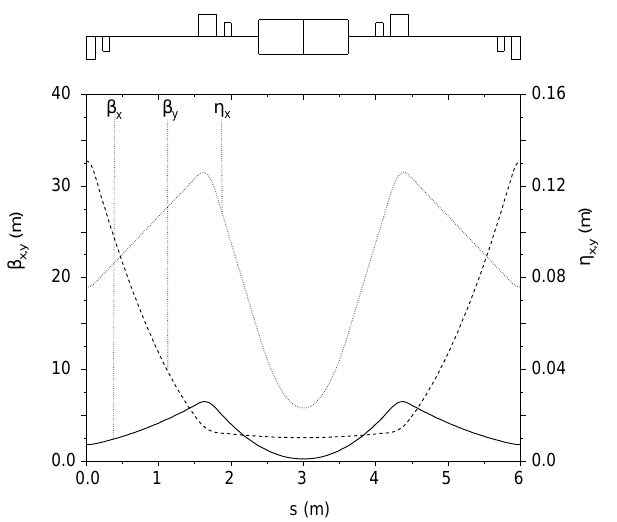
FIG. 6. Optical functions for the same three-quad TME cell as in Fig. 5 assuming a defocusing gradient of 66 kG (cid:1) m in the bending magnet.